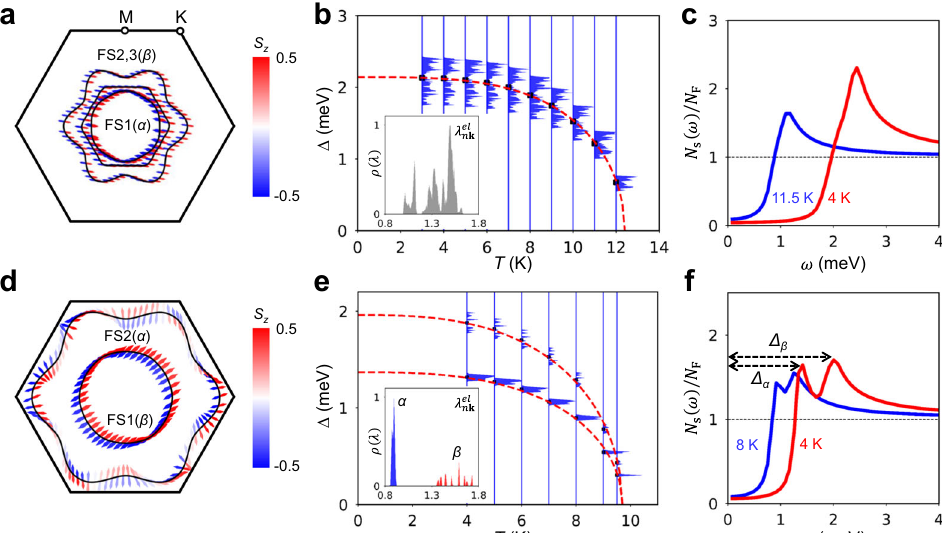
Fig. 3 Superconducting properties. a Fermi surface (FS) with in-plane spin textures of monolayer ZrCl. The arrows show the in-plane spin orientations and the opposite spins at k and − k points are anti-parallel, indicating a spin-singlet s -wave pairing. b Temperature-dependent superconducting gap distribution of monolayer ZrCl based on anisotropic Migdal-Eliashberg theory. The red dashed line in b represents α - model fi tting using the average gap values (black square dots) and the inset is the density distribution of EPC strength λ el superconducting quasiparticle DOS of monolayer ZrCl at 4 K and 11.5 K. d – f FS with in-plane spin texture, temperature-dependent superconducting gap distribution, and normalized superconducting quasiparticle DOS of monolayer MoCl, respectively.